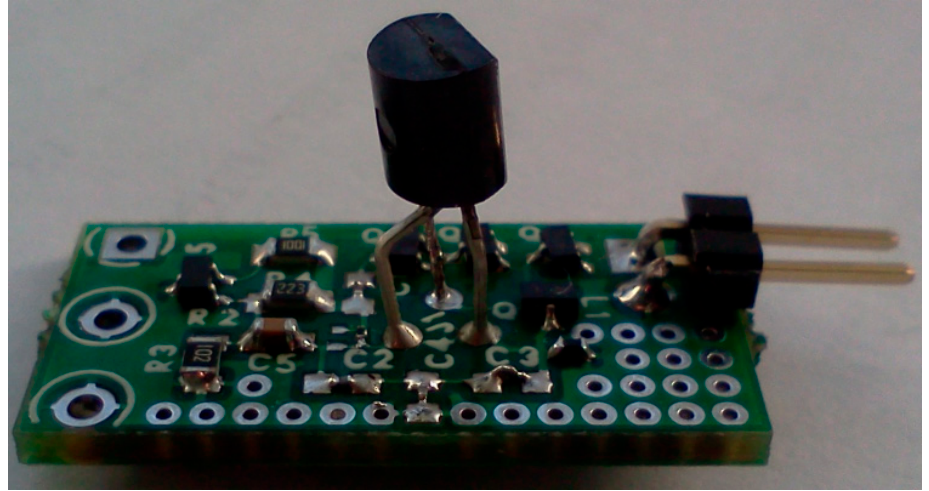
Figure 30. Printed circuit board assembly of the oscillator with multiple-output improved Wilson current mirror ( m = 0). Table 16. Circuit elements used in the oscillator with MIWCM assembled on a printed circuit board.